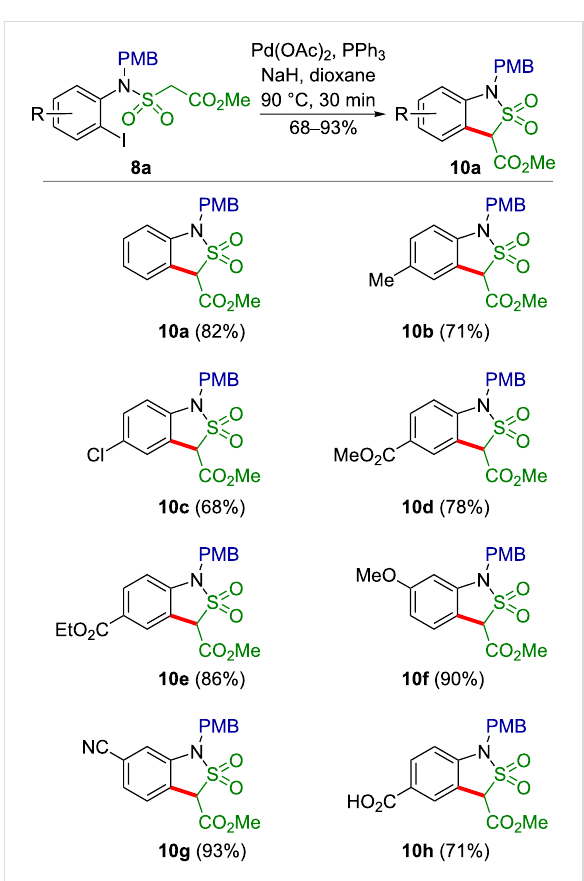
Scheme 4: Synthesis of arene-annelated sultams 10 by Pd-catalyzed intramolecular arylation of a C–H acidic methylene